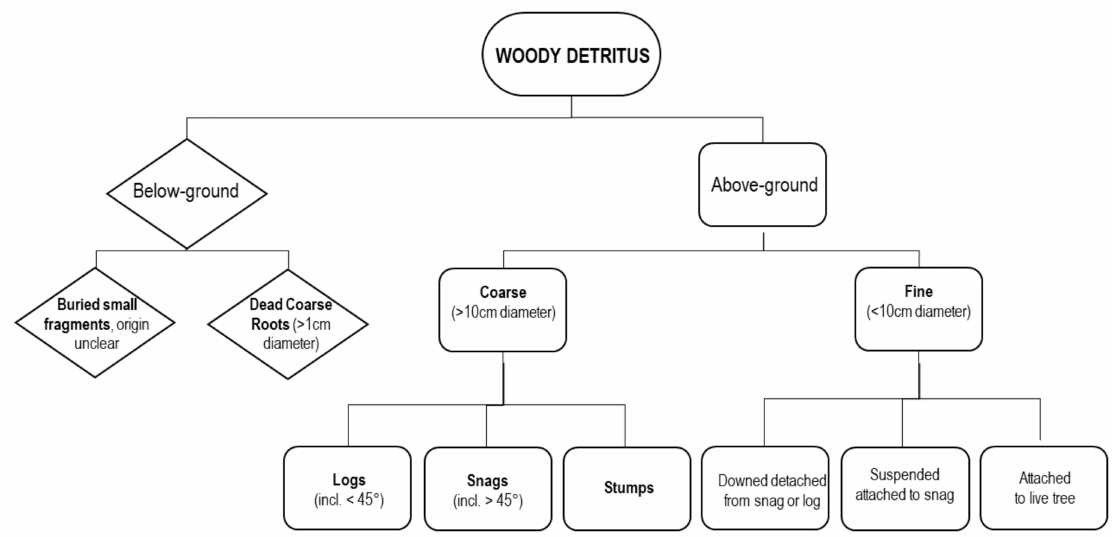
Figure 1. Identification key for deadwood elements (from Reference [39],